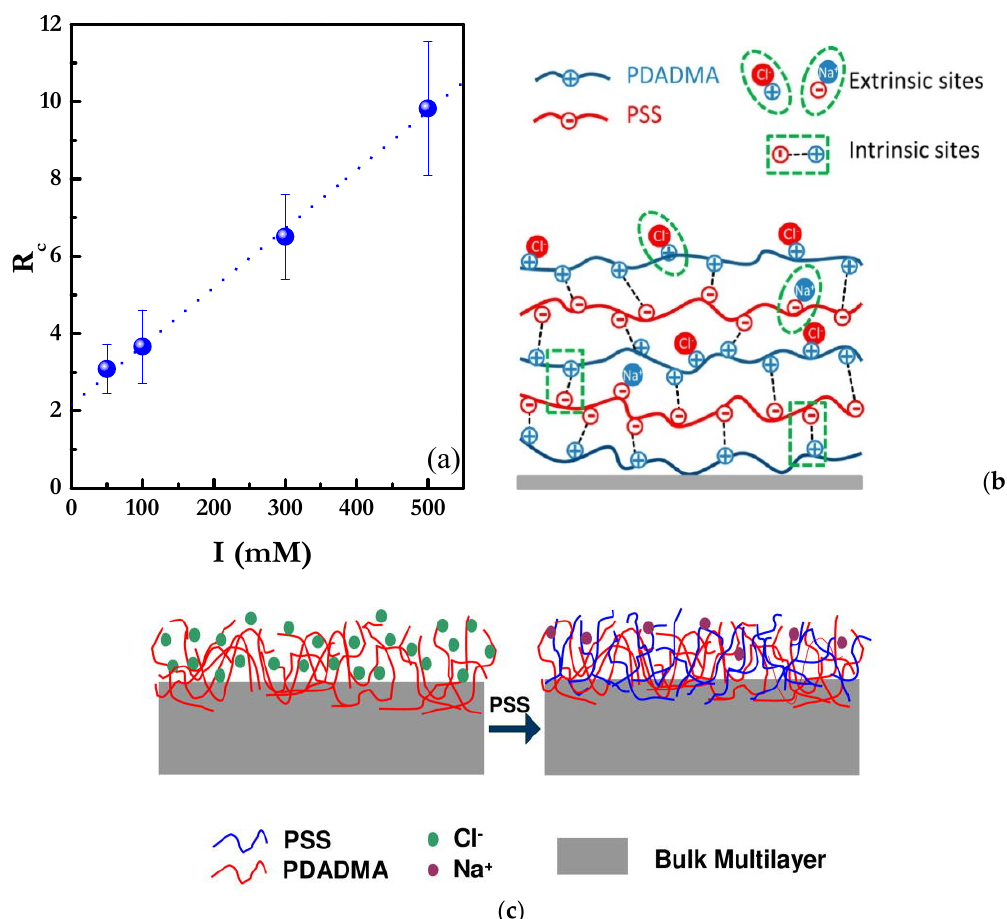
Figure 4. ( a ) Compensation ratio R c in (PDADMAC - PSS) n multilayers as a function of the ionic strengths. Data adapted from reference [89] , Copyright (2009), with permission from The Royal Society of Chemistry. ( b ) Sketch displaying the general internal charge balance in polyelectrolyte multilayers. Reprinted from reference [140] . Copyright (2013), with permission from American Chemical Society. ( c ) Representation of the asymmetrical compensation in polyelectrolyte multilayers as a function of the nature of the last deposited layer. Reprinted with permission from reference [149] . Copyright (2012) American Chemical Society.